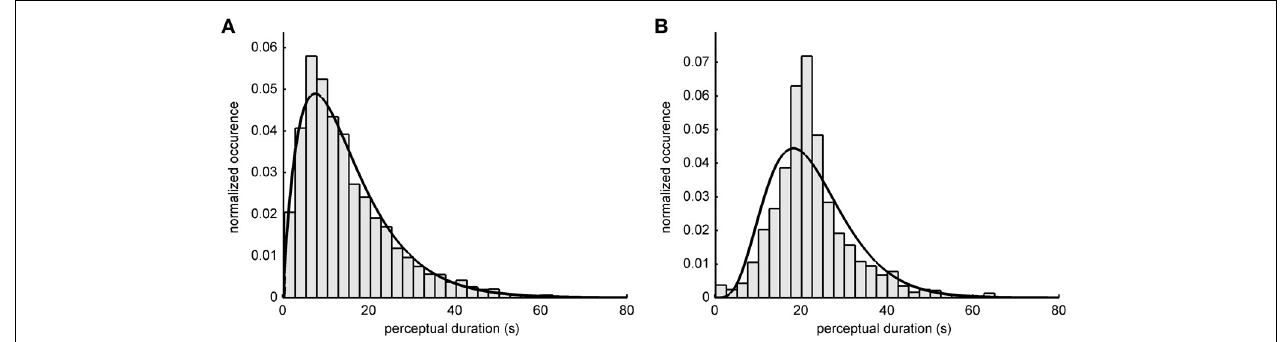
FIGURE 2 | Perceptual switch intervals. Histograms show the relative occurrence how long a perceptual state lasted for (A) 15 participants of the offline experiment and (B) 10 participants of the online experiment. A gamma probability density function (pdf) was fitted to the